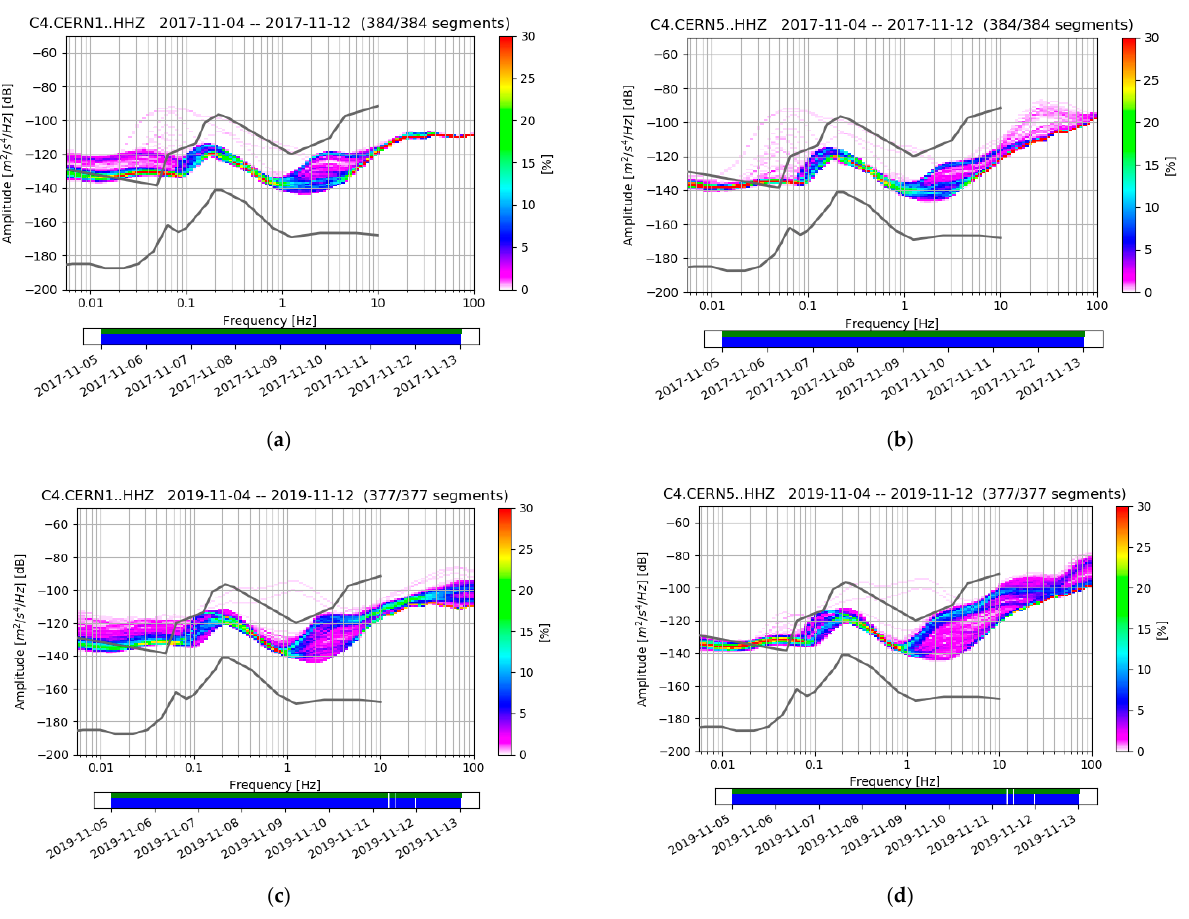
Figure 10. PPSD graphs for vertical direction: ( a ) example week of normal seismic activity—seismic station at Point 1 (close to ATLAS detector); ( b ) example week of normal seismic activity—seismic station at Point 5 (close to CMS detector); ( c ) a week of earthquake swarm occurrence—seismic station at Point 1 (close to ATLAS detector); ( d ) a week of earthquake swarm occurrence—seismic station at Point 5 (close to CMS detector).